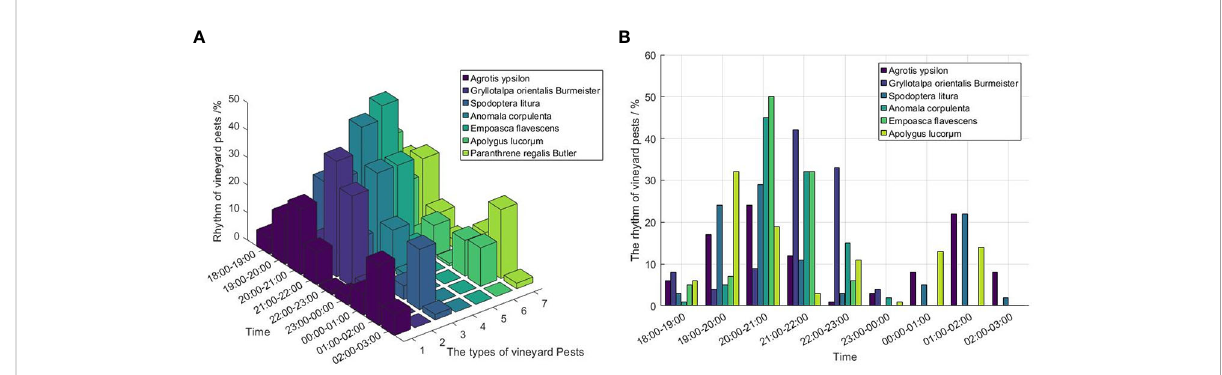
FIGURE 9 The phototactic rhythm of vineyard pests. (A) The phototactic rhythm of Agrotis Ypsilon, Gryllotalpa Orientalis Burmeister, Spodoptera Litura, Anomala Corpulenta Motschulsky, Empoasca Flavescens, Oriental Mole Crickets, Spodoptera Litura, Apolygus Lucorum and Paranthrene Regalis Butler in vineyard, (B) The bar chart of Rhythm for Agrotis Ypsilon, Gryllotalpa Orientalis Burmeister, Spodoptera Litura, Anomala Corpulenta Motschulsky, Empoasca Flavescens, Oriental Mole Crickets, Spodoptera Litura, Apolygus Lucorum and Paranthrene Regalis Butler in vineyard.